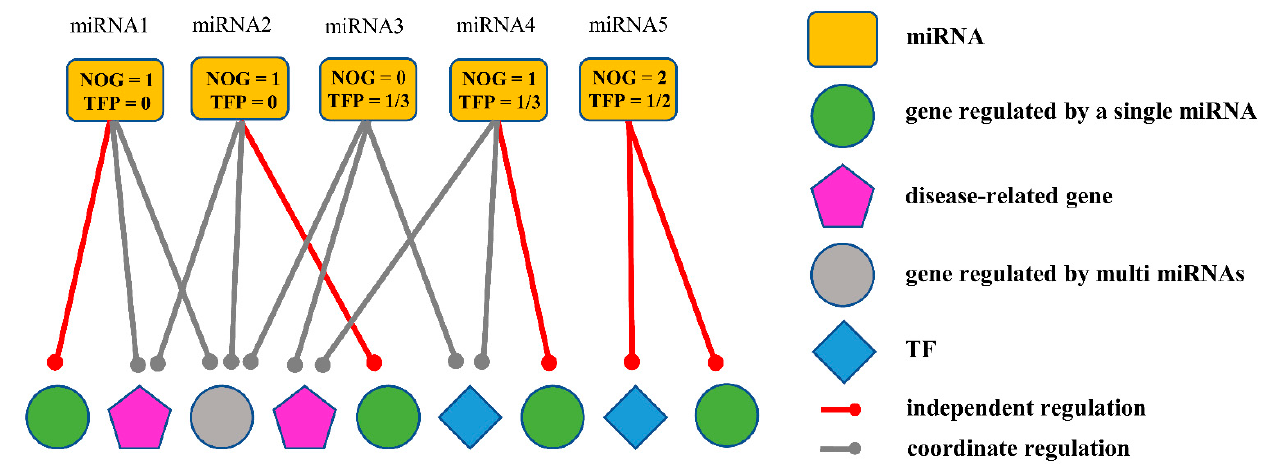
Figure 1. MiRNA-mRNA regulatory network combines the independent regulatory model with the biological function of target genes. MiRNA4 is more likely to be a marker than other miRNAs in the figure because its targets include independent genes, TF genes, and important disease-related genes.